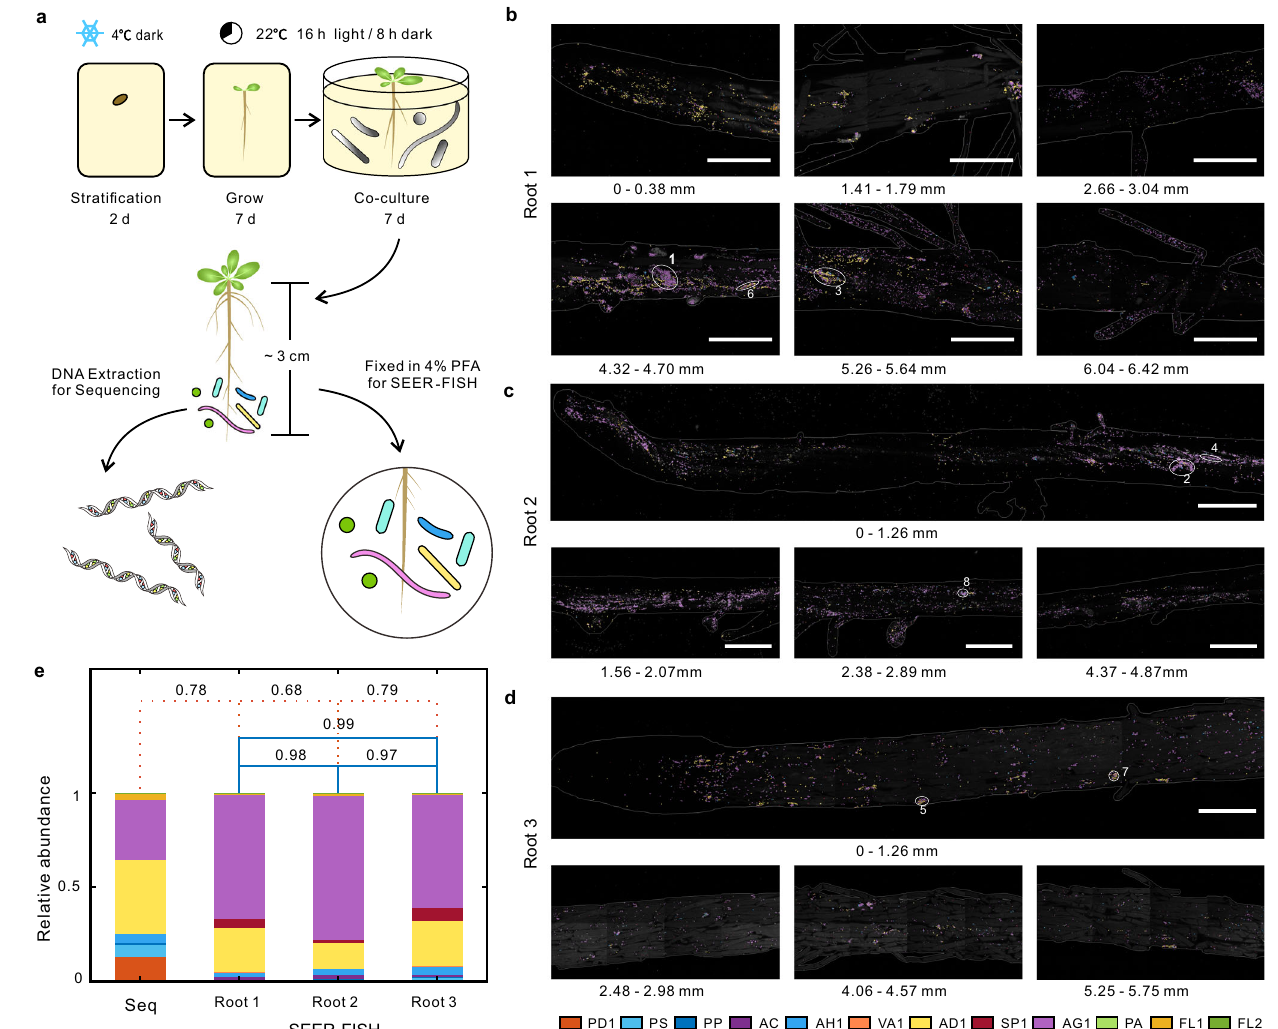
Fig. 4 | Spatial pro fi ling of microbial communities colonized on Arabidopsis roots by SEER-FISH. a The protocol of synthetic microbial community coloniza- tion on Arabidopsis roots. Arabidopsis seeds were germinated on an MS plate and then colonized by a synthetic community of 12 bacterial species for 7 days under hydroponic conditions. b – d The colonization of 12-species synthetic community on different regions of 3 independent roots as identi fi ed by SEER-FISH. The edges of the root (white lines) are drawn manually based on the phase-contrast image.